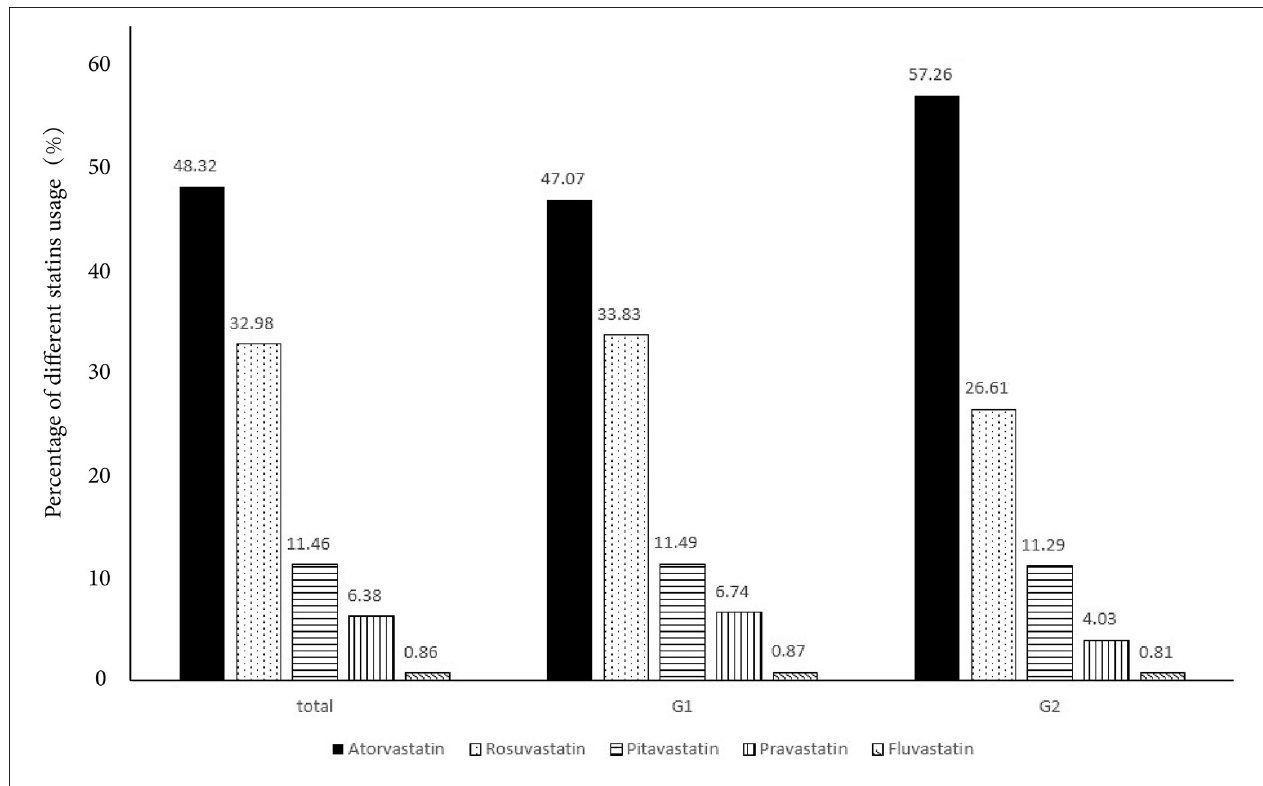
FIGURE 2 | The percentage of different statins used in total and different groups.